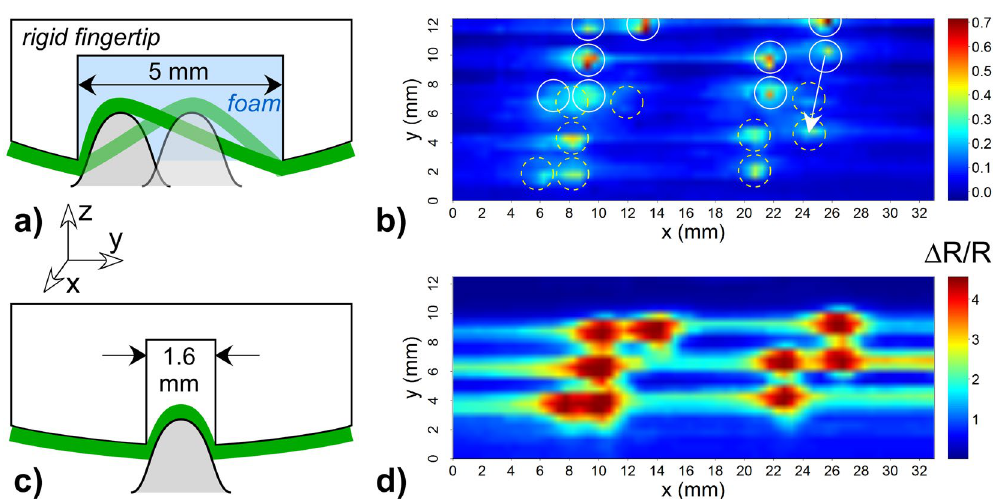
Figure 4. ( a ) Schematic representation of the first finger, with a foam-filled groove, and the interaction of a braille dot with the sensing membrane, represented as a green line. The vertical scale is exaggerated for clarity. ( b ) The corresponding discrete scan image. The peak Δ R/R values for each touch are indicated by the color, with maximum values in red and the baseline in blue. (Note: the color scales in the images vary.) The x -direction in the image is along the groove. The braille pattern is overlaid (circles with solid lines), as is ghosting (dashed lines). ( c ) A finger with a narrower, air-filled groove. ( d ) The corresponding discrete scan